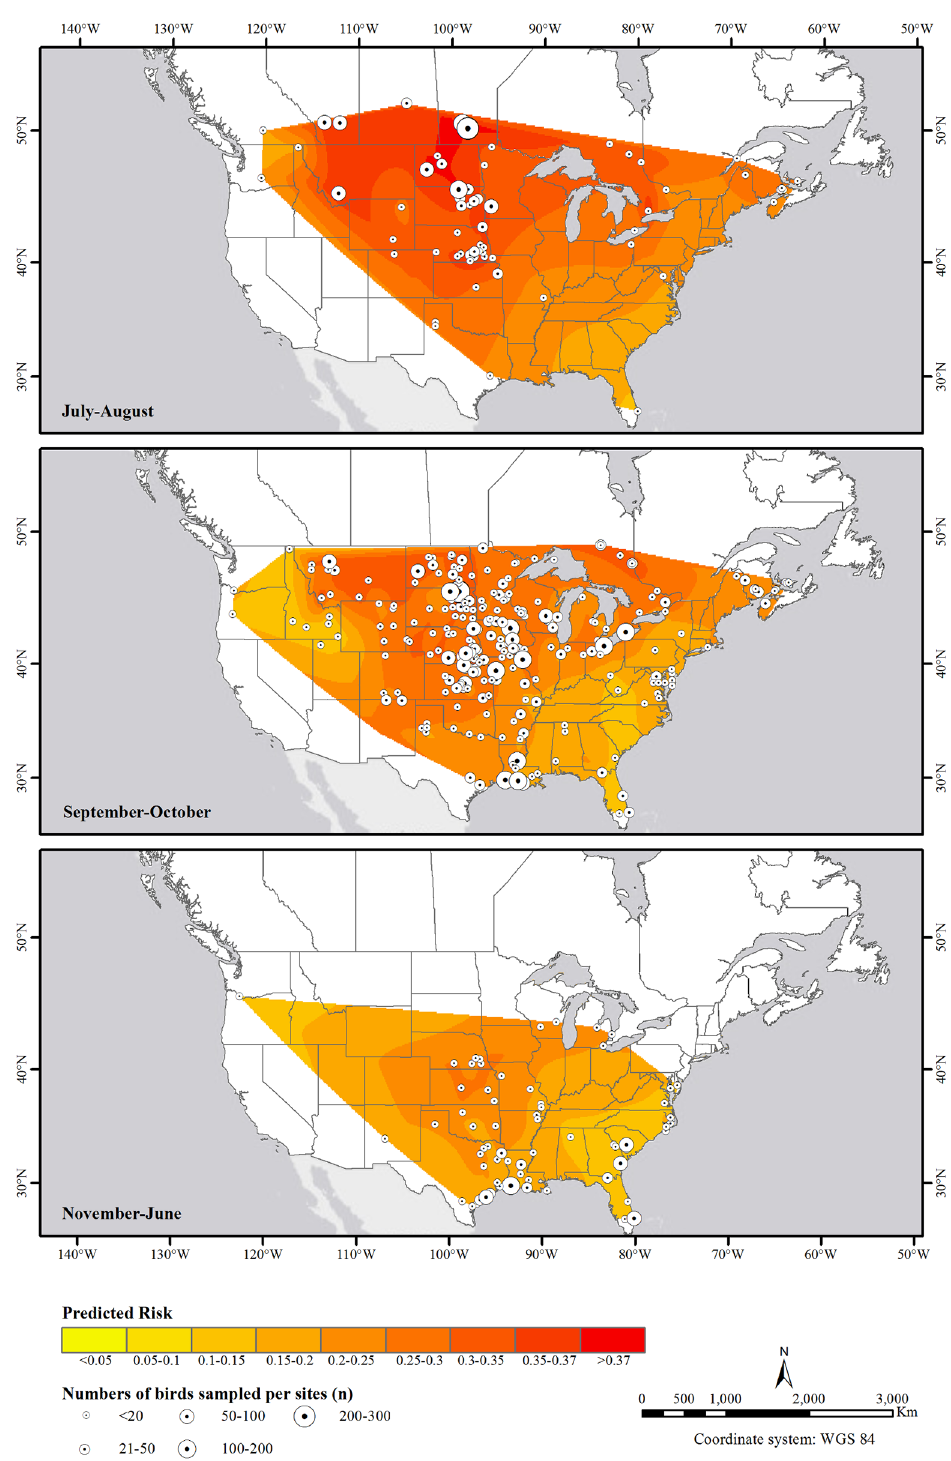
Fig 5. Predicted risk of avian influenza virus infection in hatch year Blue-winged Teal in Canada and the US from 2007 – 2010 at different stages of the annual life cycle. Natural neighbor interpolation spatial analysis was applied to predicted probability values calculated for all hatch year birds based on the best- supported model (Table 3), and averaged across all years and both sexes for each sampling site (circles).